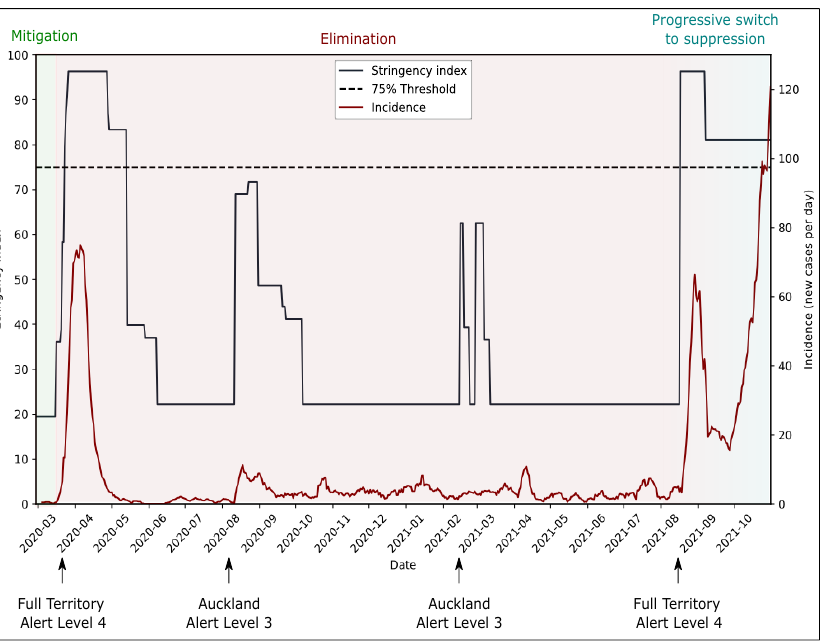
Figure 2. Evolution of governmental stringency index and incidence of daily SARS-CoV-2 cases over time in New Zealand along with adopted policy strategies. From the definition elaborated by Hale et al., the stringency index is a composite measure of 9 response metrics capturing closing and containment measures to represent the restrictiveness of policy measures on a scale from 0 to 100 [17]. The incidence corresponds to the number of new SARS-CoV-2 cases per day corrected with a 7-day rolling average [13]. An arbitrary threshold of 75 was set for the stringency index to highlight periods that had strong governmental measures associated with high incidence. Incidence was high from March to mid-April 2021 and started rising again in September 2021. The elimination strategy was proven to be effective in lowering the incidence with little restriction during this period of